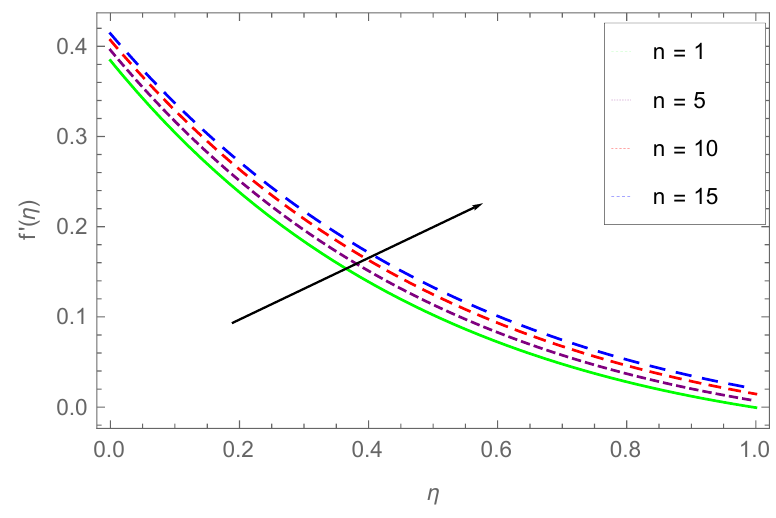
Figure 5. Variation of f (cid:48) ( η ) with n .